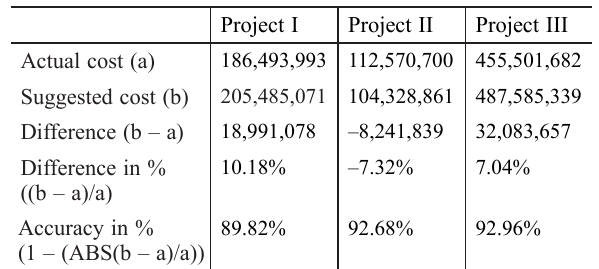
Table 7. Evaluation results of three case studies using the proposed